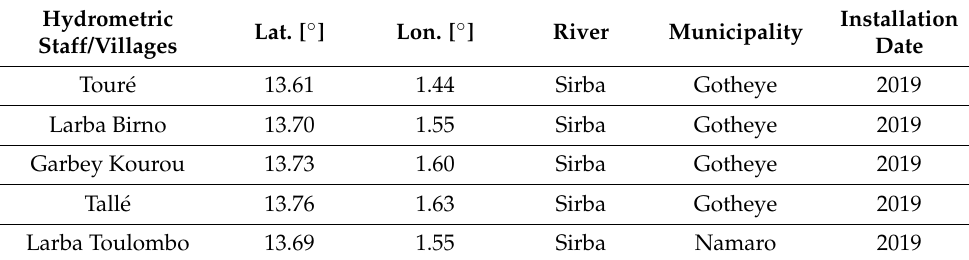
Table 2. Colored hydrometric staffs of Sirba River Basin. Hydrometric Lat. [ ◦ Staff/Villages